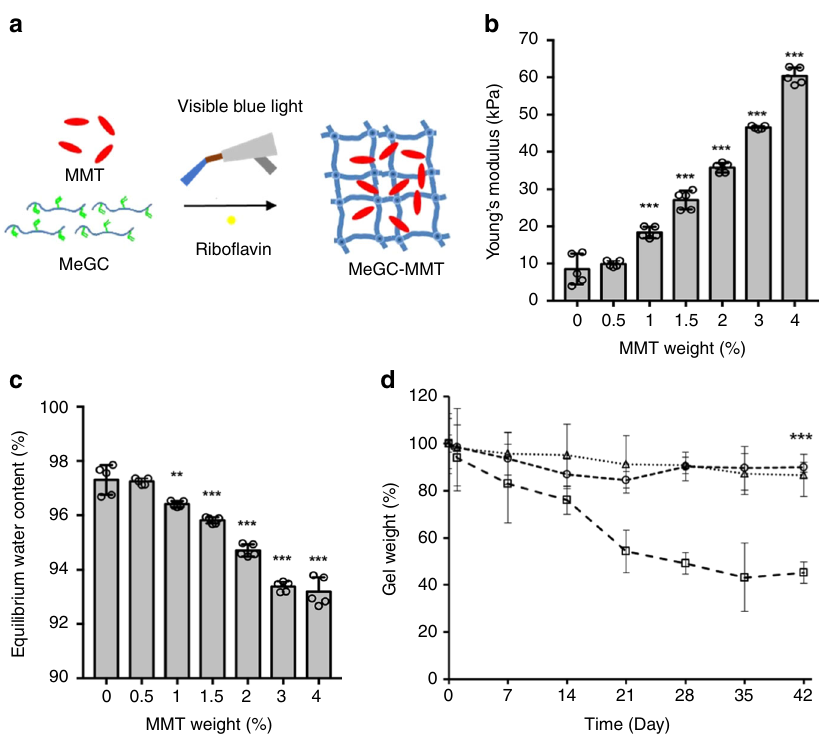
Fig. 1 Characterization of photocross-linked MeGC-MMT nanocomposite hydrogels. a Schematic illustration of MeGC-MMT hydrogel cured by visible blue light cross-linking with ribo fl avin as the photoinitiator in the presence of MMT. b Young ’ s modulus of MeGC-MMT nanocomposite hydrogels with various amount of MMT. c Equilibrium water content of MeGC-MMT nanocomposite hydrogels. d Degradation pro fi les of MeGC-MMT nanocomposite hydrogels in the presence of 0% (square), 1.5% (circle), and 3% (triangle) MMT in PBS at 37 °C for 42 days. Error bars indicate standard deviation ( n = 5). * p < 0.05, ** p < 0.01, and *** p < 0.001 compared with the control MeGC group with 0% MMT (ANOVA followed by Tukey ’ s post hoc